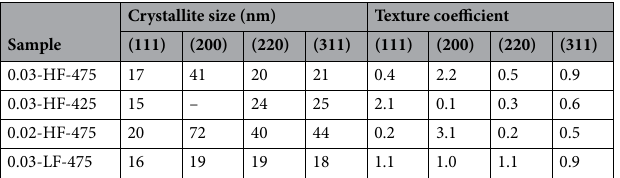
Table 1. Crystallite sizes obtained using the Scherrer formula and the texture coefficients for the deposited CeO 2